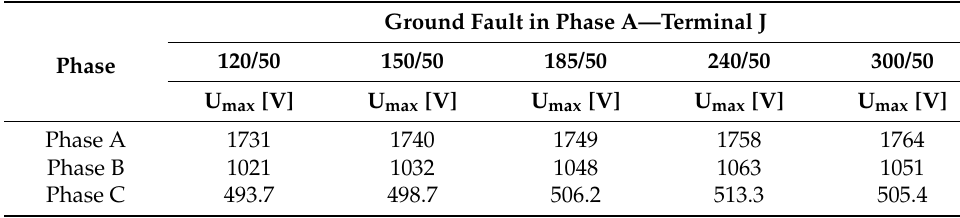
Table 5. Maximum overvoltages for different cross-sections of conductors.